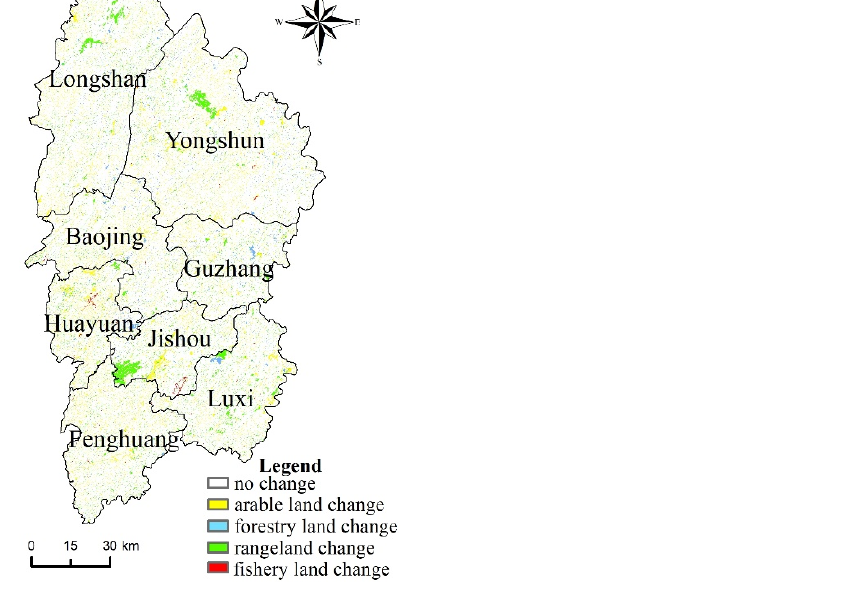
Figure 3. Spatial distribution of agricultural land change from 2000 to 2018. Table 4. Agricultural land change between 2000 and 2018.